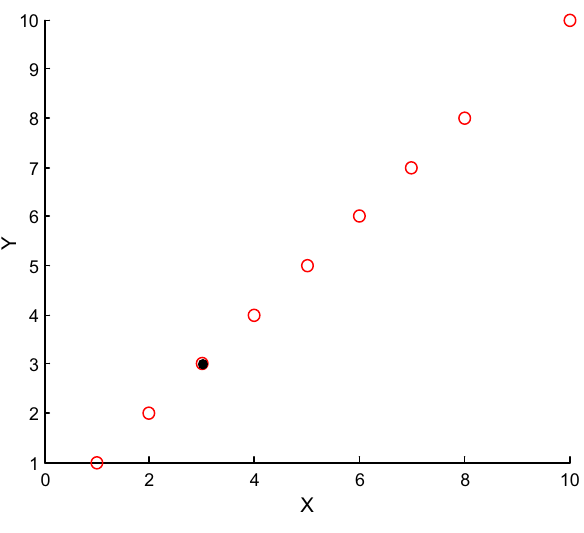
Fig. 2 Cluster of water quantity and flow timings